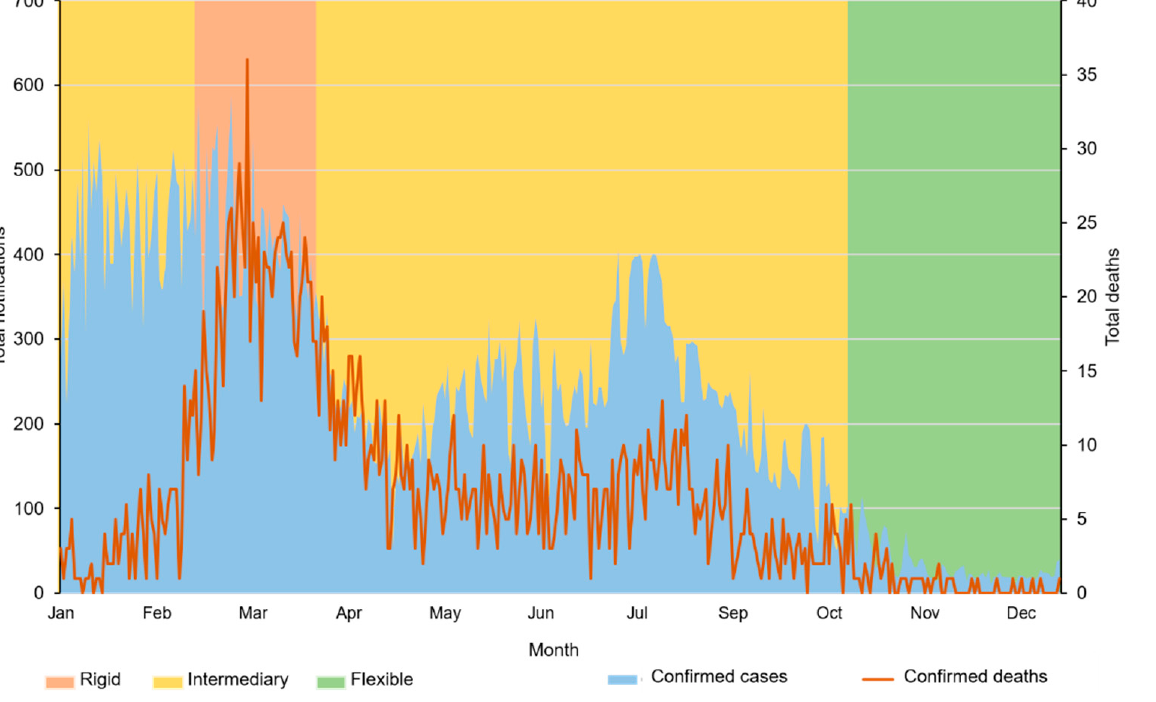
Figure 3. Distribution of deaths and registered cases according to the date of notification to the Municipal Health Department of Uberlândia (MG).